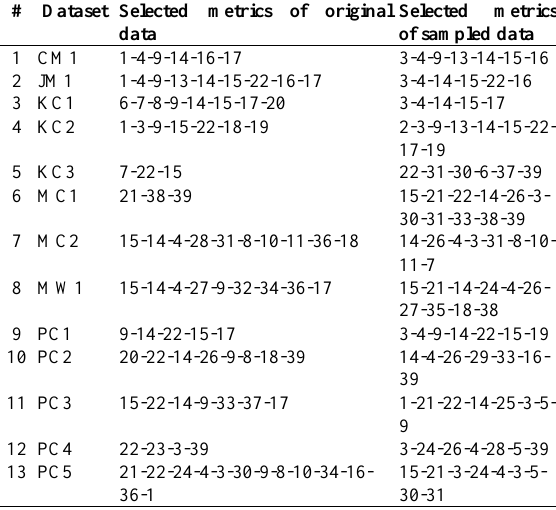
Selected metrics of sampled data